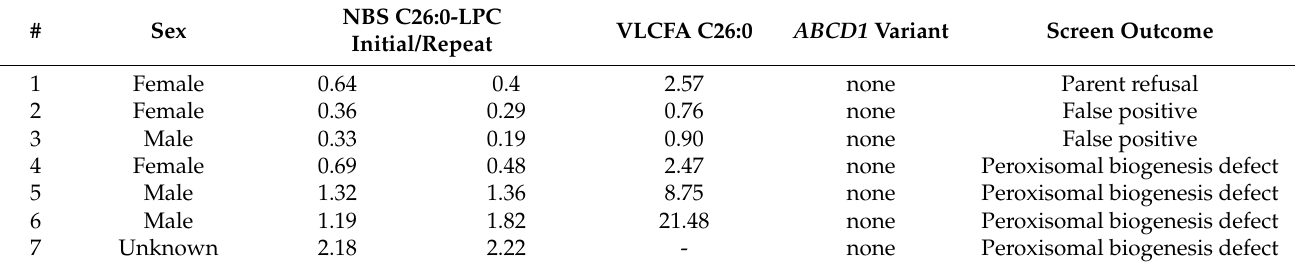
Table 2. Newborn screen, biochemical, and molecular features of seven Pennsylvanian infants who screened positive for X-ALD between 1 April 2017 and 26 May 2021 and did not harbor ABCD1 variants. Newborn screening was considered positive for second-tier LC-MS/MS quantitation of C26:0-LPC > 0.15 µ mol/L on initial and repeat dried blood spot specimens. First-tier results from FIA-MS/MS are not shown. Confirmatory biochemical testing with C26:0 quantitation was performed on a clinical basis (reference range: 0.17–0.73 µ mol/L). “-” denotes that the clinical information was unavailable. All units are in µ